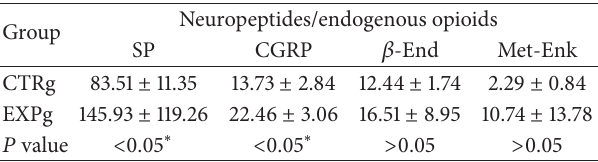
Table 1: Expression levels for substance P (SP), calcitonin-gene related peptide (CGRP), 𝛽 -endorphins ( 𝛽 -End), and methionine- enkephalin (Met-Enk) in the control group (CTRg) and the asymp- tomatic inflammation group